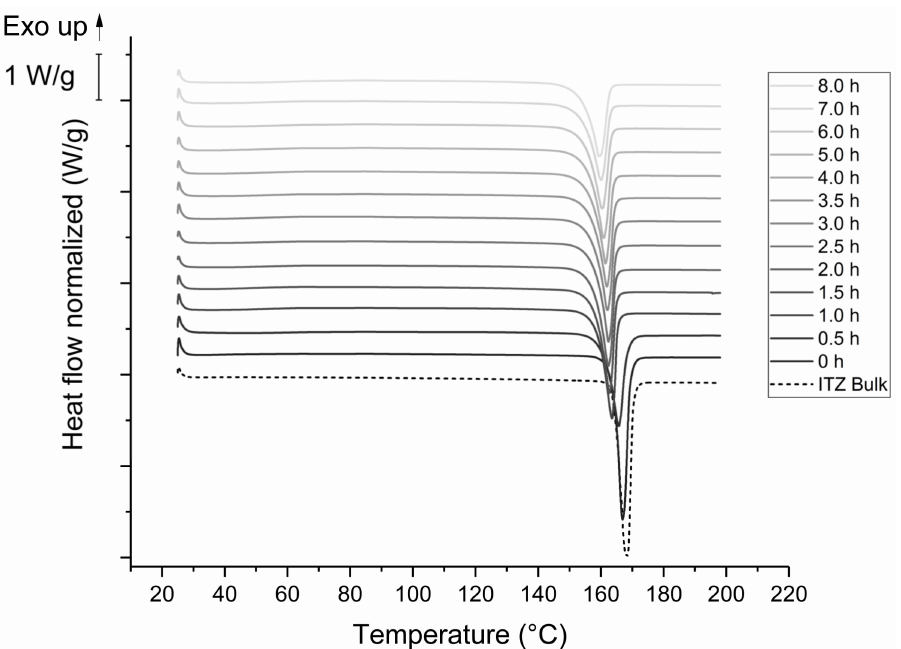
Figure 7. DSC-thermograms of F6 ITZ nanosuspension. Milling was carried out at 4 ◦ C with 1500 rpm and milling beads sized 0.3–0.4 mm. Plots are shifted for a better illustration.